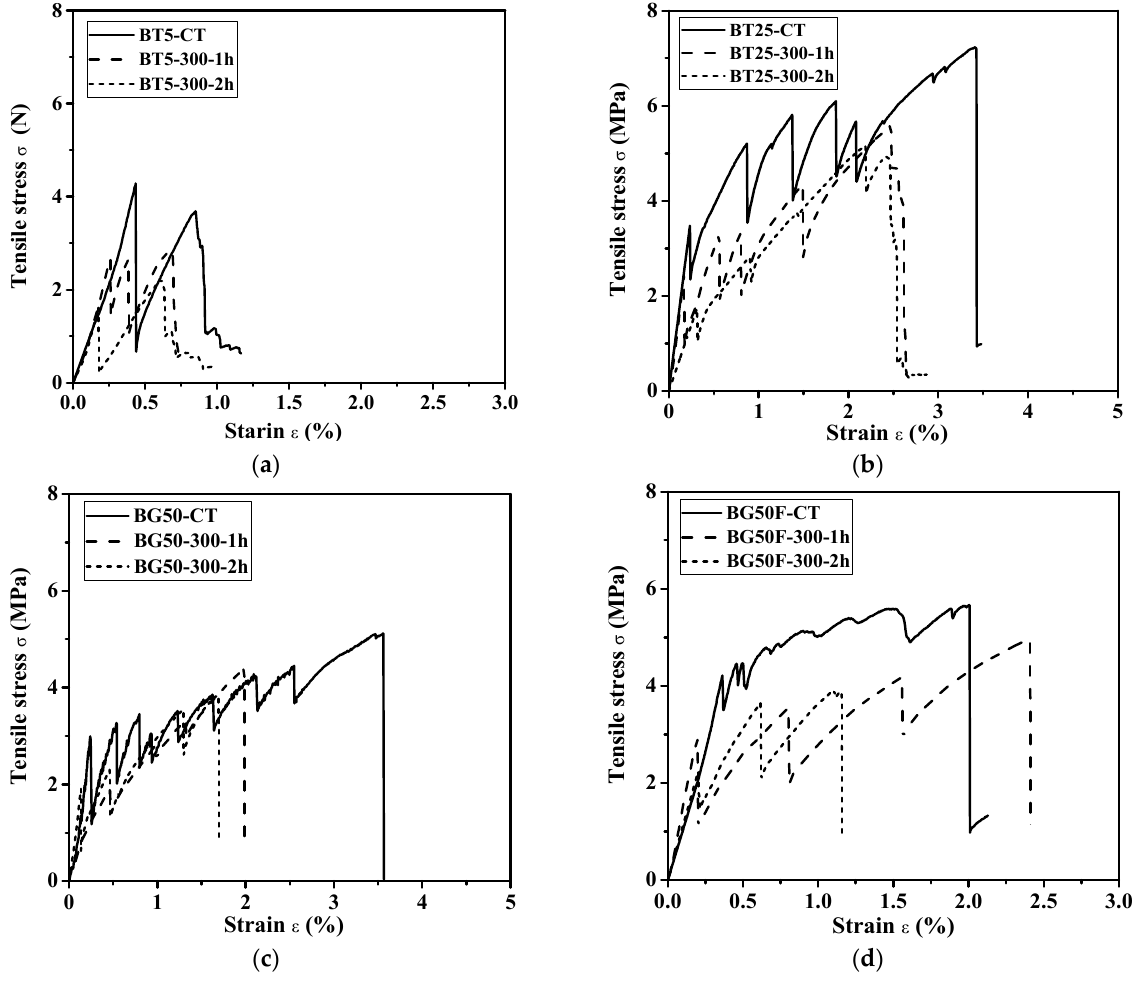
Figure 11. Tensile stress–strain curve of the BGRM after exposure to elevated temperature: ( a ) BT5; ( b ) BT25; ( c ) BG50; ( d ) BG50F.